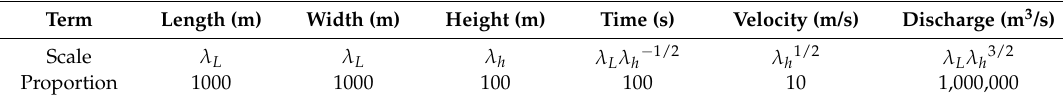
Table 2. Scale ratio of the prototype and the model.